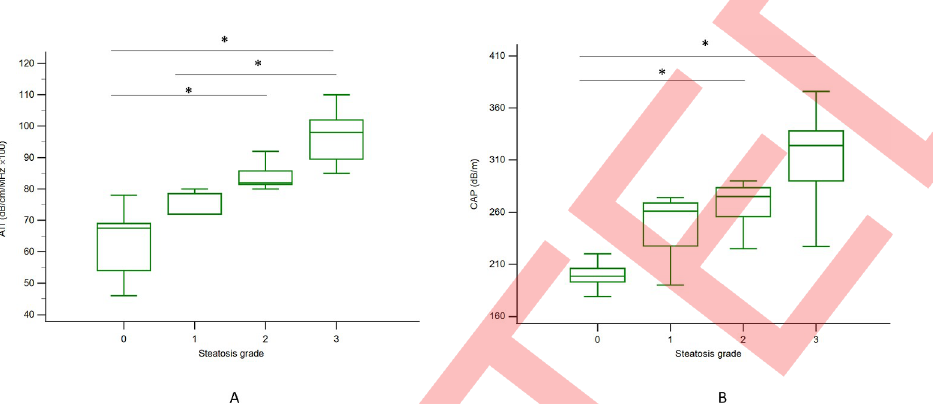
Fig 3. The distribution of CAP and ATI values according to histologic steatosis grade. A: ATI was significantly different between S0 and S2, S0 and S3, and S1 and S3 (p < 0.05) with the Kruskal–Wallis test in the post hoc analysis. B: The CAP assessment results were significant between S0 and S2 and S0 and S3, with p < 0.05. The vertical axis is a logarithmic scale. The top and bottom of the boxes are the first and third quartiles, respectively. The length of each box represents the interquartile range, within which is located 50% of the values. The lines through the middle of the boxes represent median values. ATI: attenuation imaging; CAP: controlled attenuation parameter, � : p < 0.05.